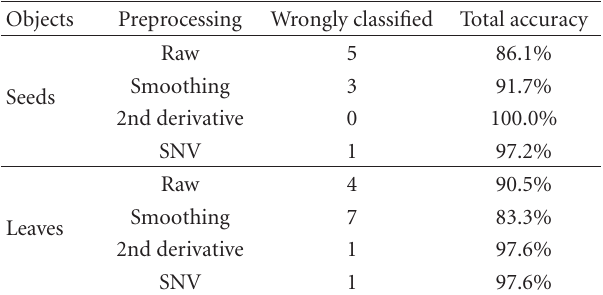
Table 4: Classification results of test set with di ff erent preprocessing